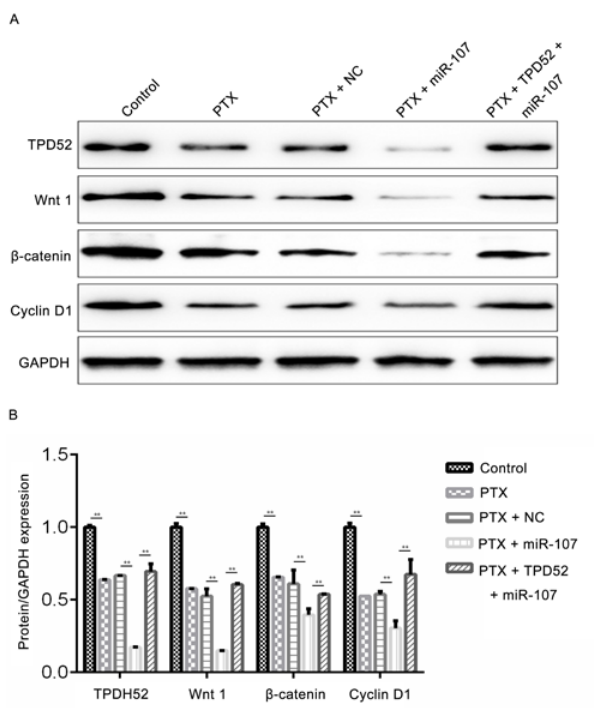
Figure 9: Effect of miR-107 on the protein expression levels of TPD52, Wnt1, β-catenin and cyclin D1. (A) The protein expression levels of TPD52, Wnt1, β-catenin and cyclin D1 in different groups; (B) The corresponding quantified results of A was presented. **P<0.01, PTX vs control; PTX + miR-107 vs PTX + NC; PTX + TPD52 + miR-107 vs PTX +miR-107. Control, un-treated cells; PTX, cells were exposed to PTX with the concentration of 0.1μg/ml; NC, miR-107 mimics negative control-transfected cells; miR-107, miR-107 mimics- transfected cells; TPD52, tumor protein D52, cells transfected with pcDNA3.1-TPD52; Wnt1, proto-oncogene protein wnt-1; GAPDH, glyceraldehyde 3-phosphate